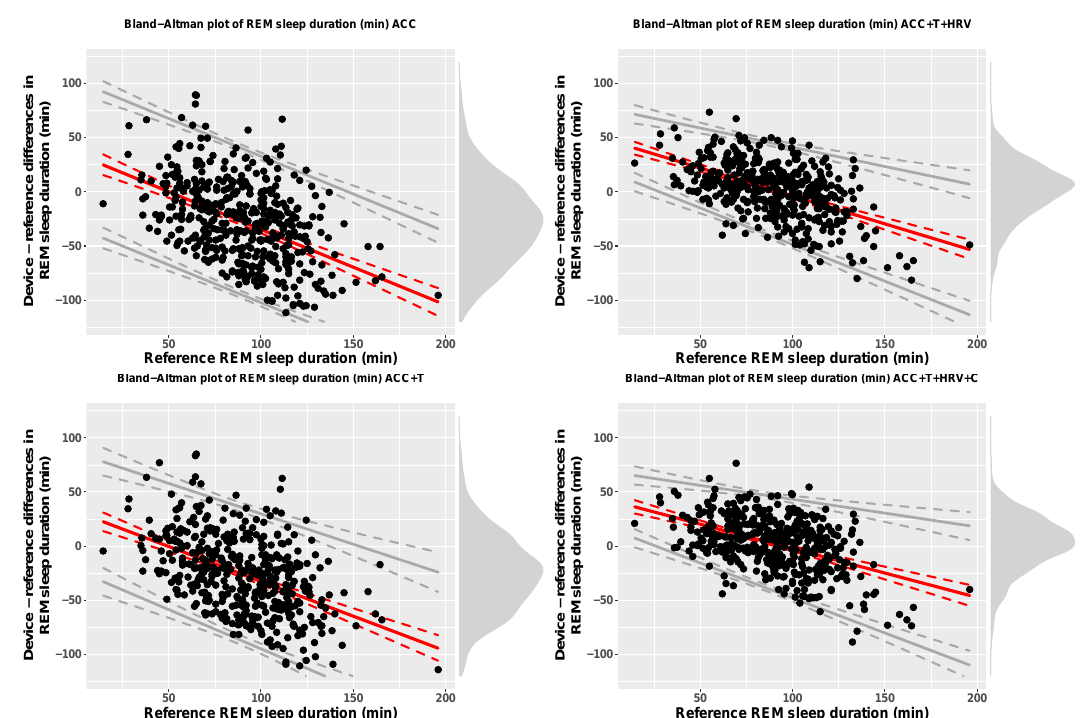
Figure 10. Bias and limits of agreement for time in REM sleep, 4-stage classification, and the four models analyzed in this paper. In Figure 11, we report epoch by epoch sensitivity, while, in Figure 12, we report epoch by epoch specificity for 4-stage classification and the four models compared in this paper. Sensitivity and specificity are also reported in Table 4.